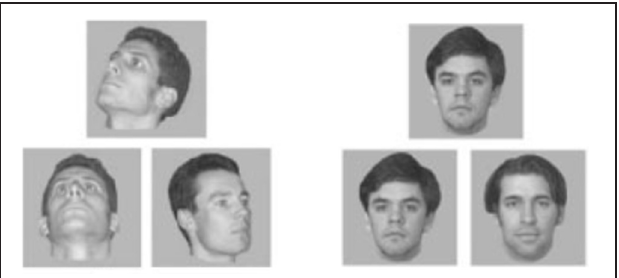
FIGURE 11 | Stimuli from the face matching task used in Barense et al. (2010b). In the right panel, the matching faces are presented from the same viewpoint, while on the left, the matching faces are presented from different viewpoints, thus requiring the comparison of multiple features. Similar viewpoint-variant faces are used in the Benton Test of Facial Recognition (Hamsher et al., 1979) (adapted from Barense et al.,